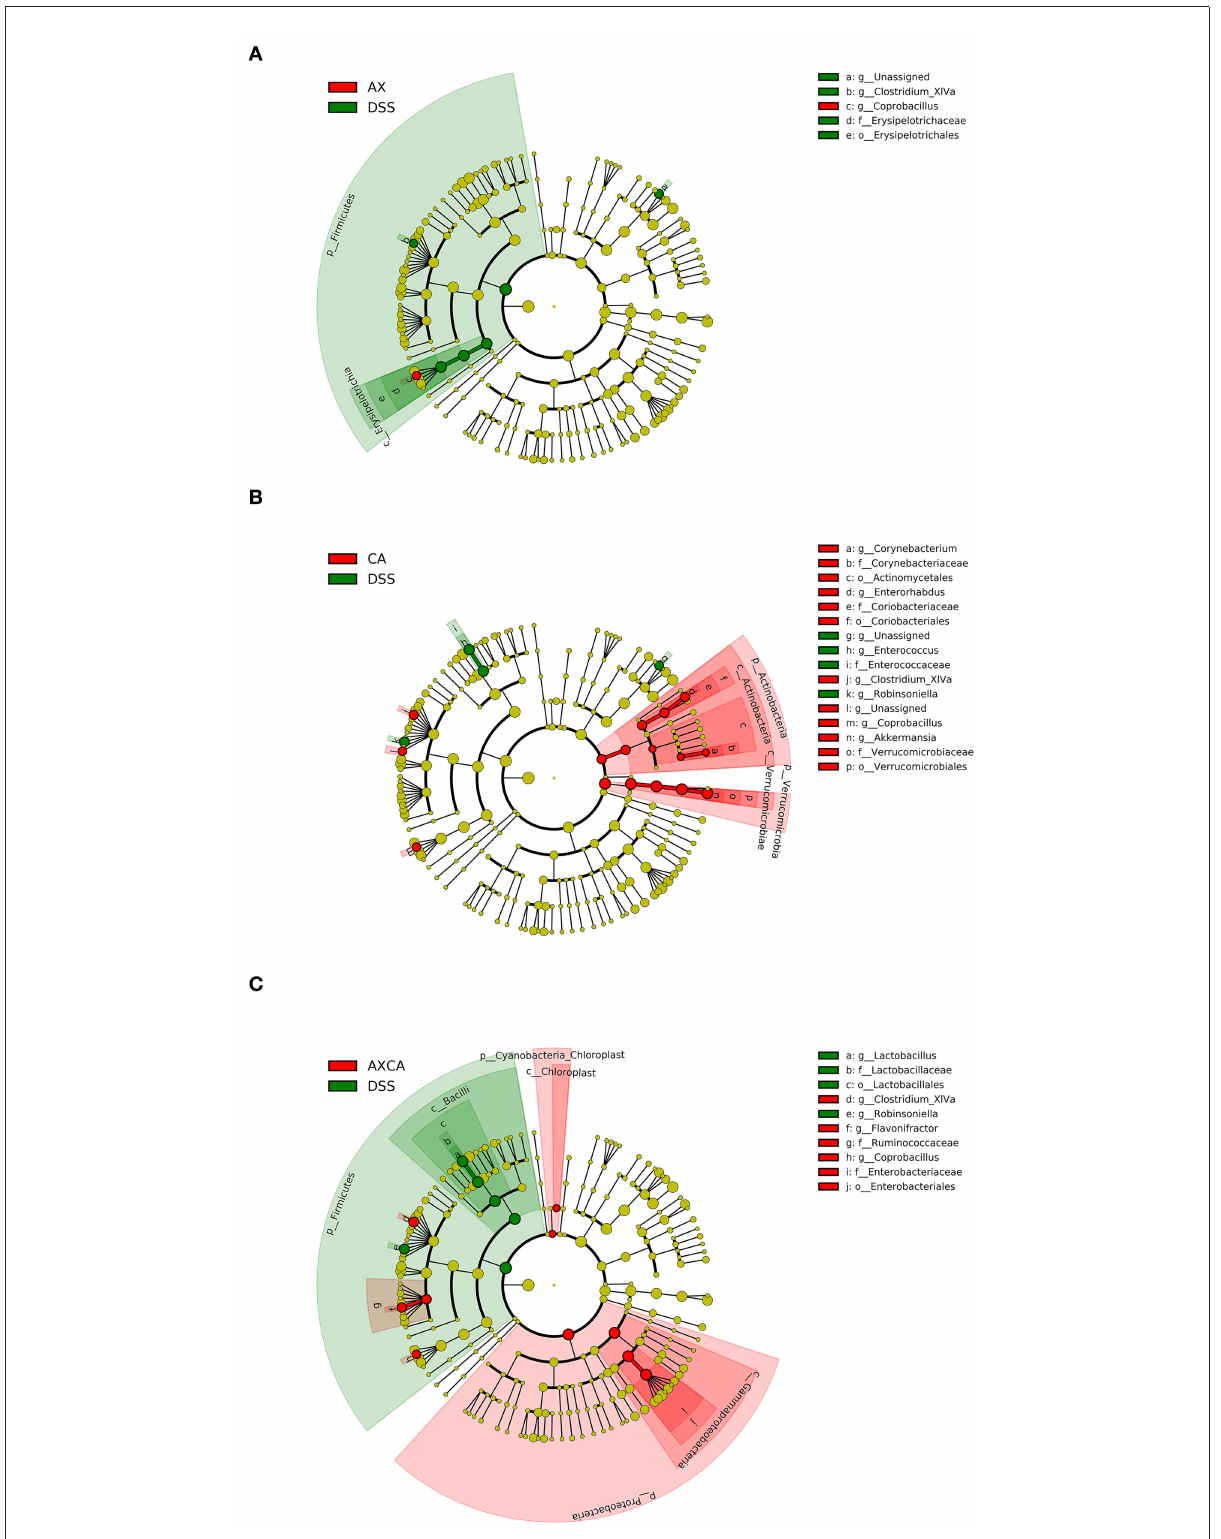
FIGURE6 LEfSe cladogram plot of the intestinal microbiota of mice in the AX (A) , CA (B) , and AX + CA (C) groups, compared to those in the DSS group.